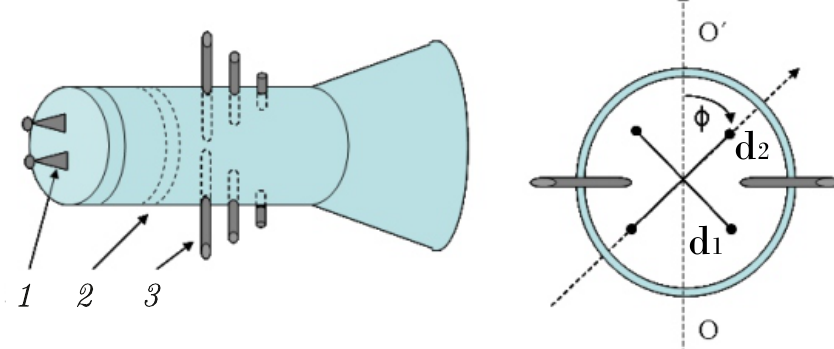
Figure 13. Geometry of the horn antenna with a polarization unit (left panel) and its cross-section showing the two orthogonal dipoles d 1 and d 2 used for the measure of the polarization (right